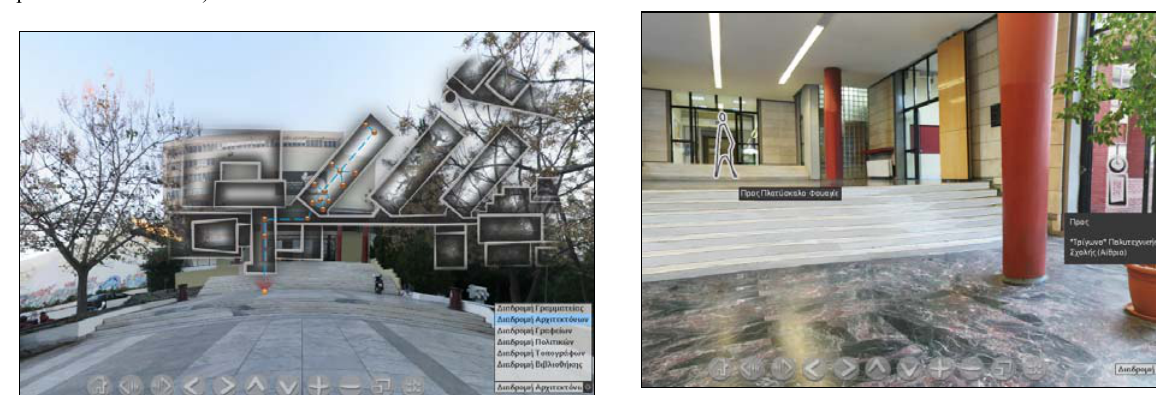
Figure 14. Map appearance over the initial screen and the paths for selection.